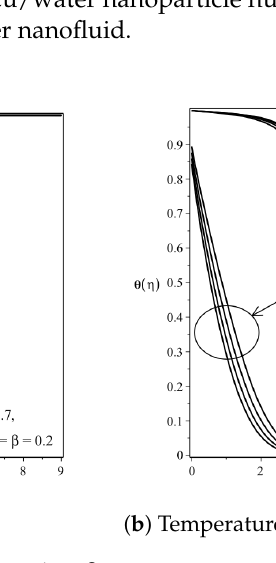
Figure 7. The flow of f (cid:48) ( η ) and θ ( η ) against S